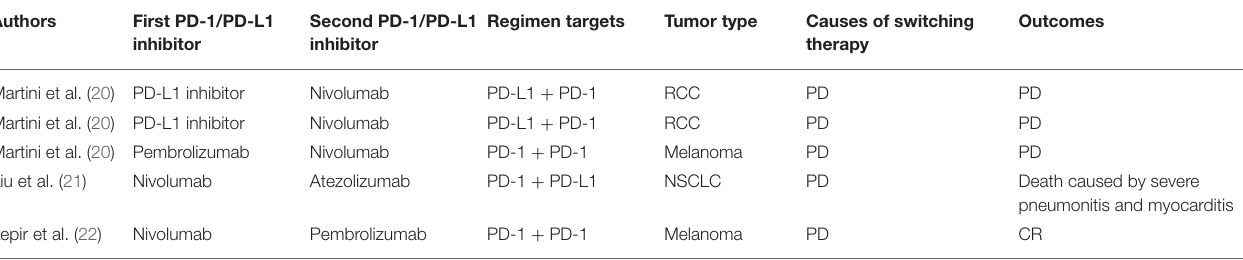
TABLE 1 | Summary of reported cases documenting sequential treatment with different PD-1/PD-L1 inhibitors.